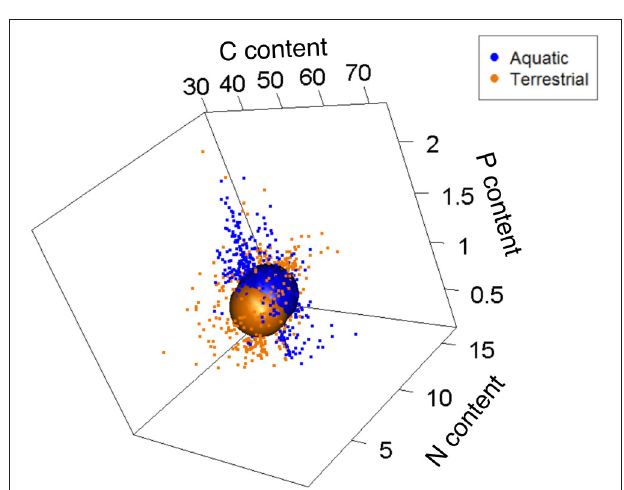
FIGURE 3 | Relative size of stoichiometric niche volumes of terrestrial and aquatic food webs (only invertebrates included). Sphere sizes depicts the volumes of the stoichiometric niches, and are centered around the average C, N, and P contents of all individuals from those variables. Dots are individual coordinates and show the variability within a given stoichiometric niche. Axes represent each element as a percentage of dry body